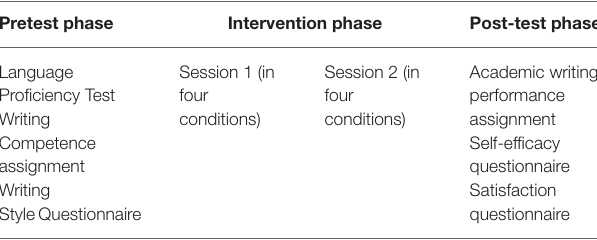
TABLE 1 | Schematic overview of the experimental